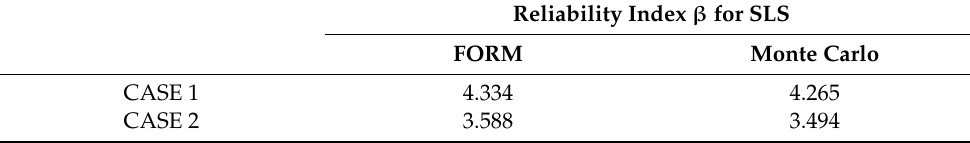
Table 5. Reliability index β for SLS.